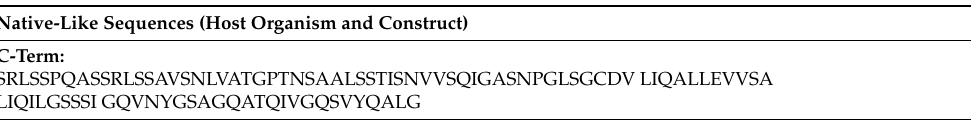
Table 1. Heterologous spider silk protein